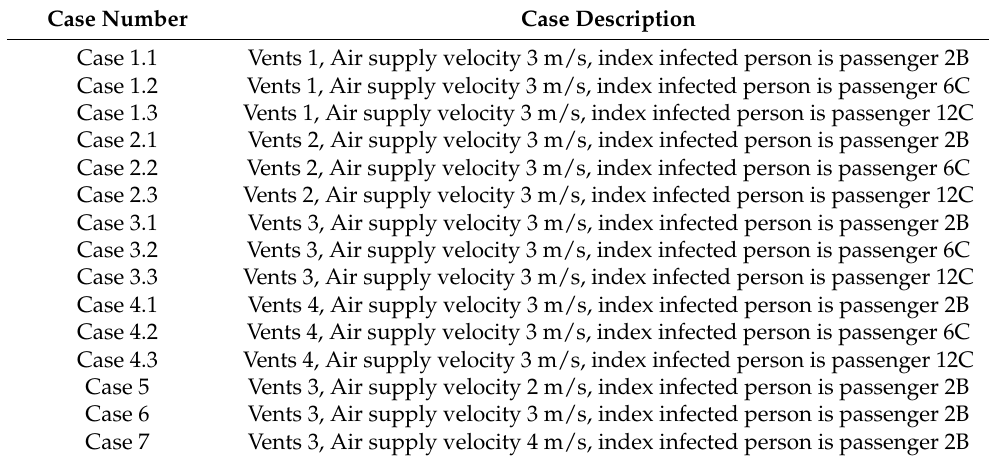
Table 1. Case description.